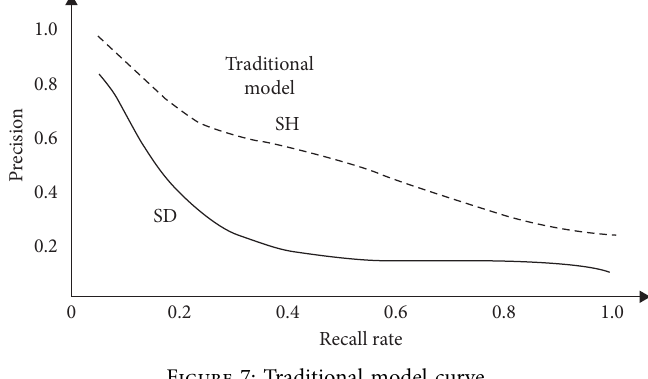
Figure 7: Traditional model curve.